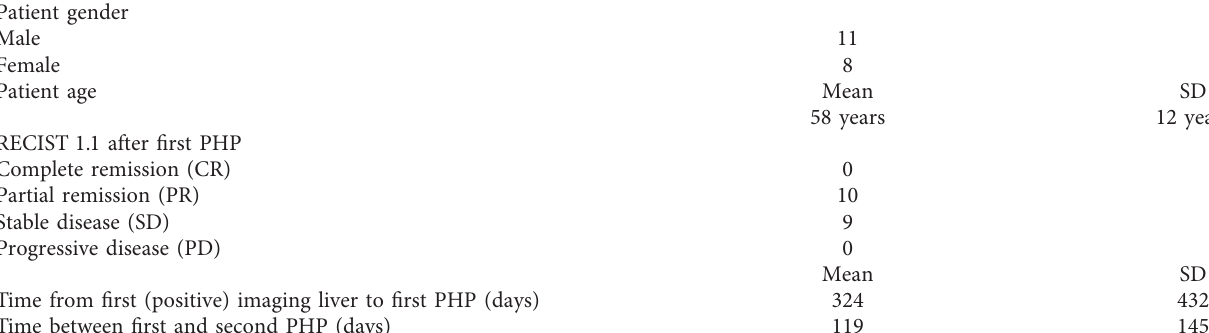
Table 1: Patients baseline data ( n �